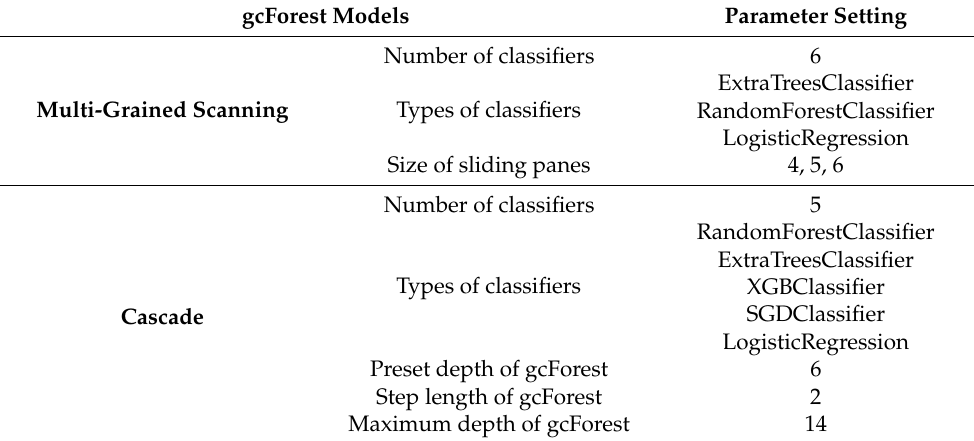
Table 5. The final parameter of gcForest.